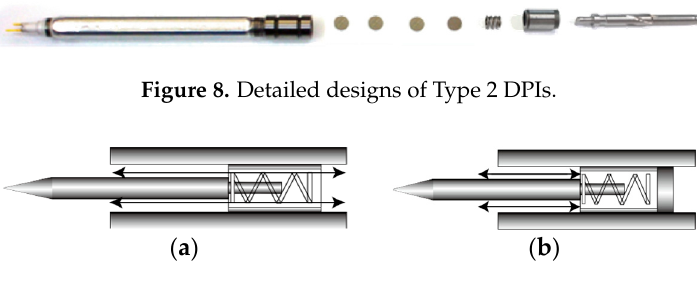
Figure 9. Comparison of needle configuration; ( a ) Type 2, ( b ) Conventional Type DPI .